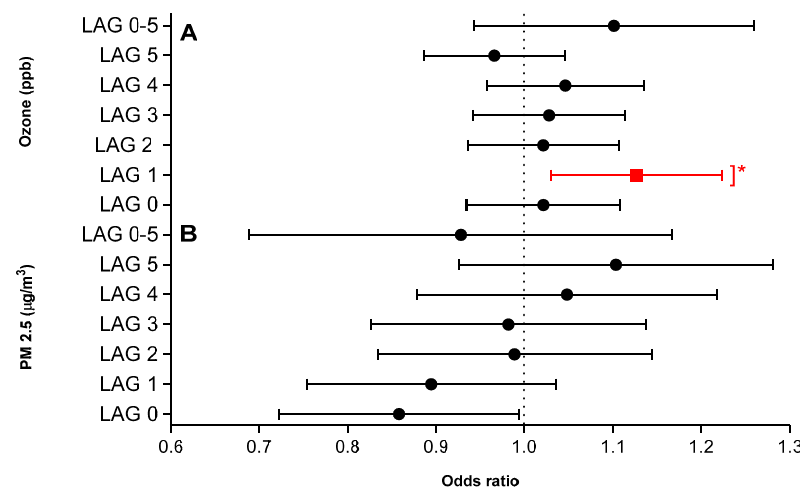
Figure 3. ( A , B ) Odds ratios of an asthma-related ED visit and significant lag days for children ages 5–17 using a two-pollutant model (single day lags and average lag, adjusted for apparent temperature (at same lag), which includes PM 2.5 and O 3 , adjusted for temperature.) Referent time period is 28 days. * p -value < 0.05.